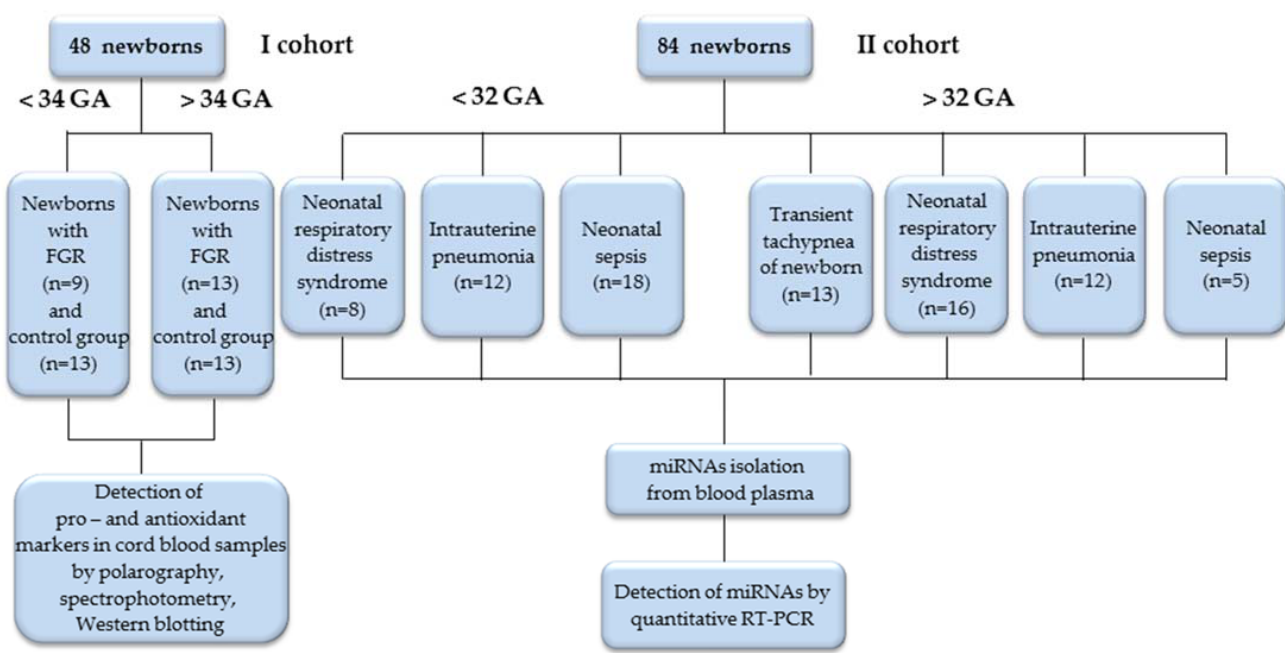
Figure 1. Flowchart of the study